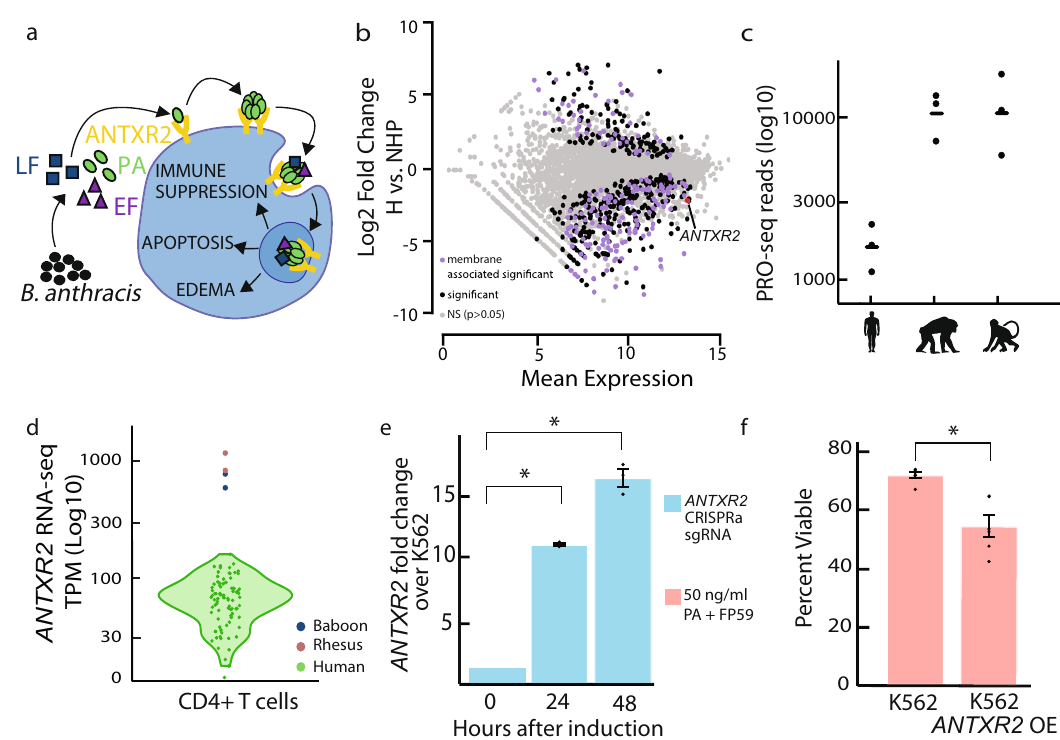
Fig. 1 Decreased ANTXR2 in humans can affect anthrax toxin sensitivity in blood cells. a B. anthracis toxins lethal factor (LF) and edema factor (EF)